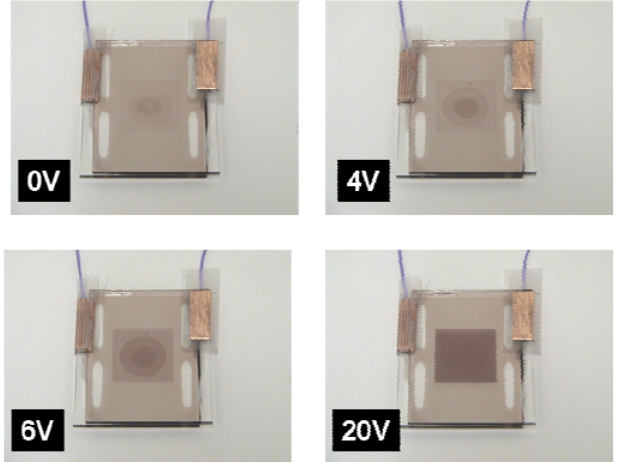
Figure 12. The performance of electrically tunable band-pass filter using dye-doped LC gels at 0, 4, 6 and 30 V . Middle: after trimming at 0 V rms 30 V rms